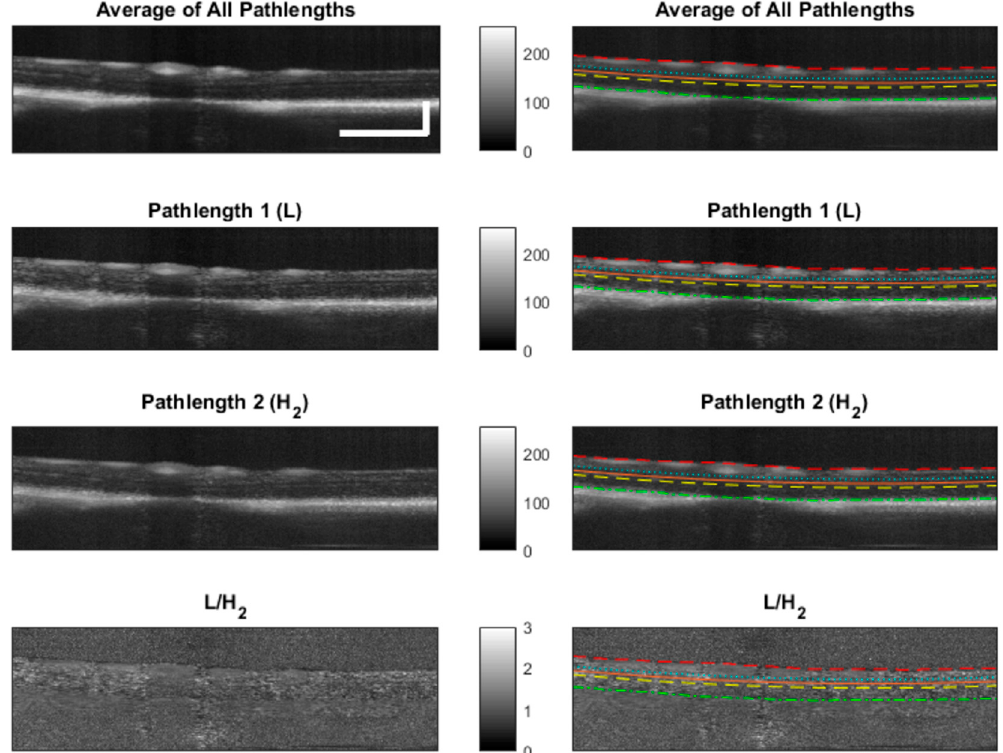
Figure 17. L/H 2 is the ratio of Pathlengths 1 and 2. The segmented retinal layers can be superimposed on L/H 2 to sort the L/H 2 values of the retina into their corresponding layers. Scale bars represent 300 μ m.